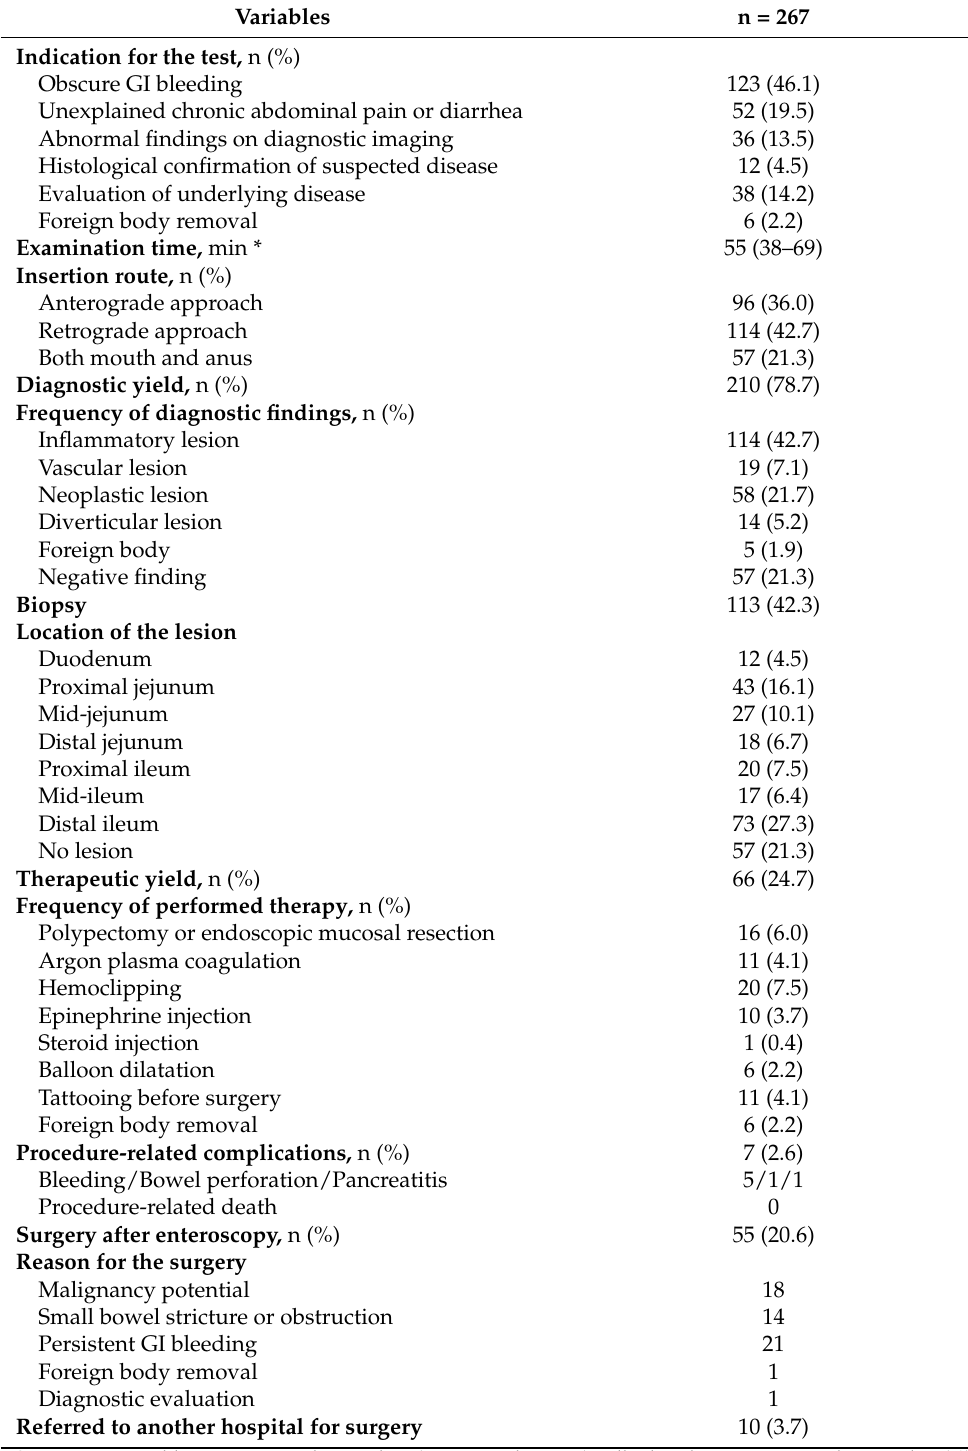
Table 2. Indications and results of double-balloon